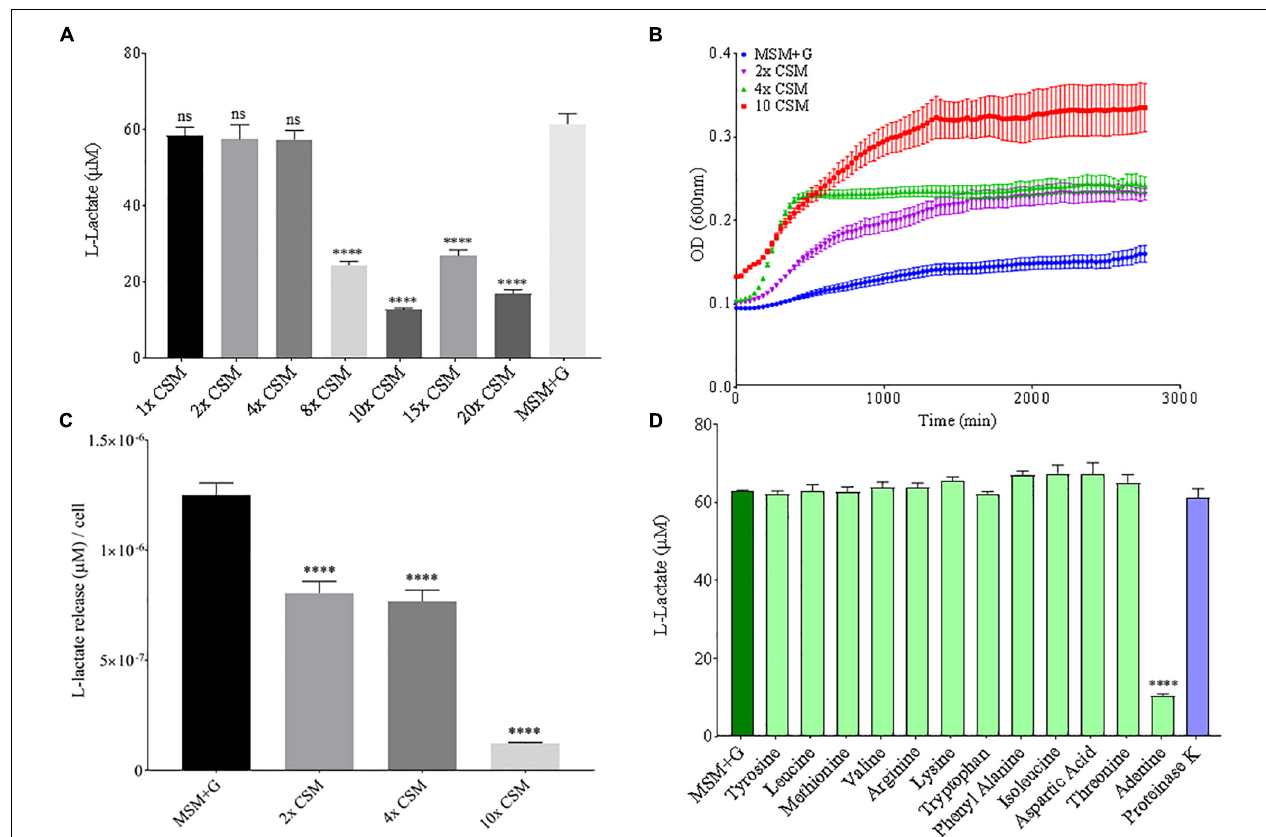
FIGURE 8 | Increasing adenine concentrations available to B. pumilus B12 leads to a decrease in L-Lactate release from PLA. (A) L-lactate release after 48 h from PLA incubated with B. pumilus B12 supplemented with increasing concentrations of complete supplement media (CSM). ∗∗∗∗ indicates ANOVA p -value ≤ 0.0001 and ns indicates ANOVA p -value ≥ 0.05 against MSM plus glucose (MSM + G) control. These assays were performed with three biological and three technical replicates. (B) 48-h growth curves of B. pumilus B12 with added concentrations of CSM. Each growth curve represents twelve biological replicates. (C) Release of L-lactate from PLA normalized for growth of B. pumilus B12 after 48 h. ∗∗∗∗ indicates ANOVA p -value ≤ 0.0001 against MSM + G. (D) L-lactate release after 48 h from PLA incubated with B. pumilus B12 with single amino/nucleic acid supplementations. All supplementations are 10-fold higher than the standard concentration found in complete supplement media. Results have been normalized to account for L-lactate released from nutrient supplementation alone. ∗∗∗∗ indicates p -value ≤ 0.0001 against MSM + G as tested by one way ANOVA compared to MSM + G. These assays were performed with three biological and three technical